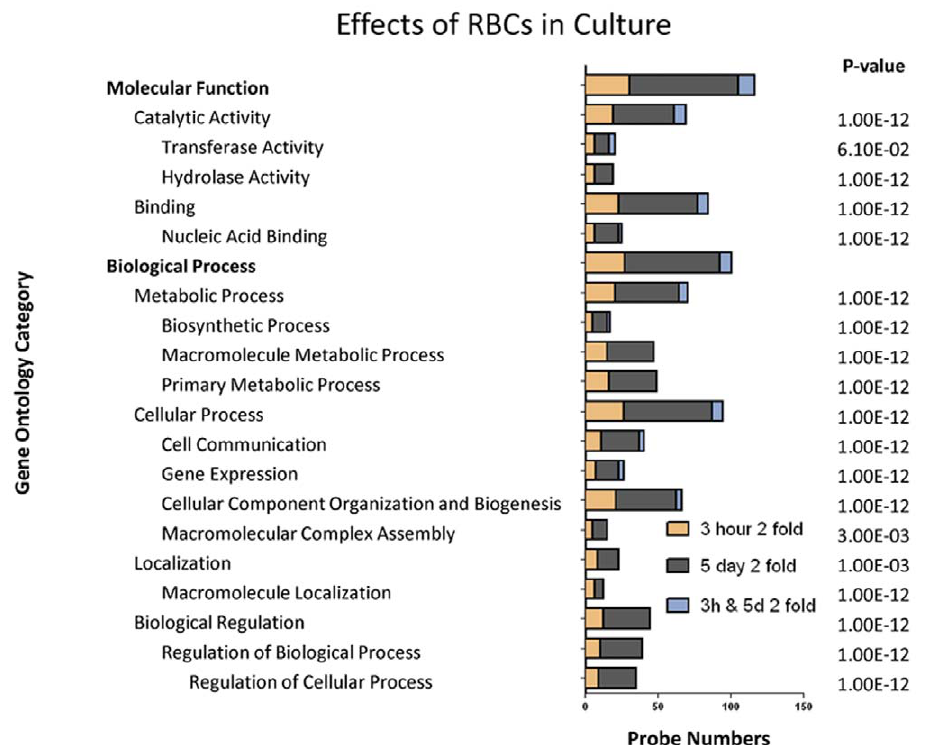
Figure 4. Major gene ontology categories of genes that were differentially expressed due to culture of S.mansoni schistosomula in the presence of erythrocytes. Gene ontologies representing the up-regulated genes in 3 h or 5 day schistosomula, and in both 3 h and 5 day schistosomula due to the presence of erythrocytes in the culture medium. P-values indicate the significance of the number and degree of differential expression within each category. Categories with a P-value # 0.05 were deemed significant; to show the position of these sub-categories within the GO tree hierarchy, parent categories with a P-value . 0.05 were also included. Categories with P-value . 0.05 may indicate that only a small percentage of the genes were differentially expressed.